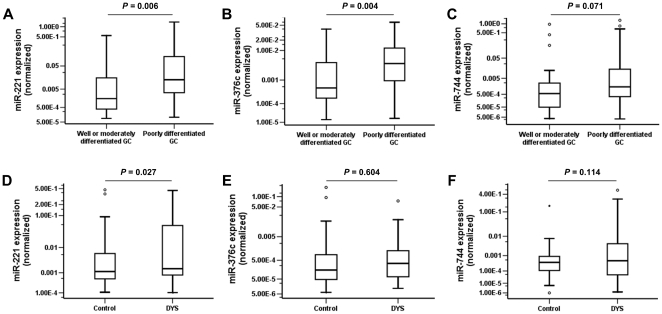
Association of the selected serum miRNA levels with GC differentiation grades and DYS.(A–C) Box plots of serum miR-221, miR-376c and miR-744 levels in 24 well or moderately differentiated and 43 poorly differentiated GC patients. (D–F) Box plots of serum miR-221, miR-376c and miR-744 levels in 46 DYS subjects and matched controls. The Mann-Whitney U tests (A–C) and the Wilcoxon tests (D–F) were performed to examine the difference between two groups, respectively. The relative levels of miRNAs (log10 scale at Y-axis) were normalized to the spiked-in cel-miR-39 (A–F).